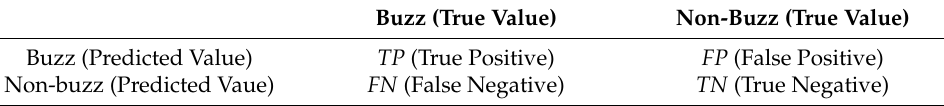
Table 3. Confusion matrix of evaluation basis.